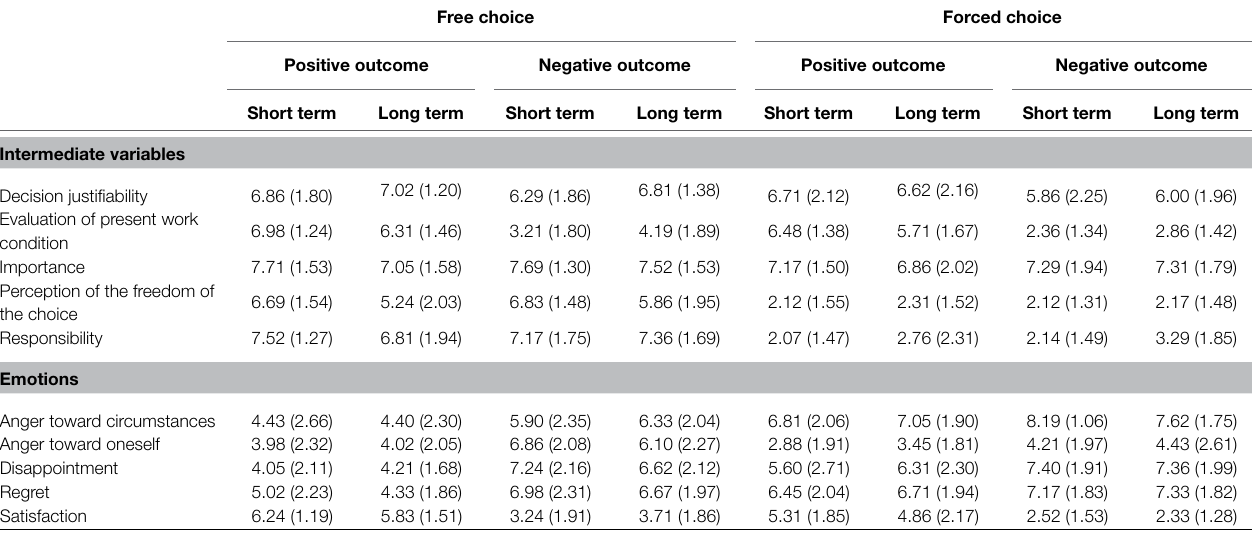
TABLE 3 | Study 2 – means and standard deviations (S.D.) of intermediate variables and emotions as a function of choice, outcome, and time. Free choice Forced choice Positive outcome Negative outcome Positive outcome Negative